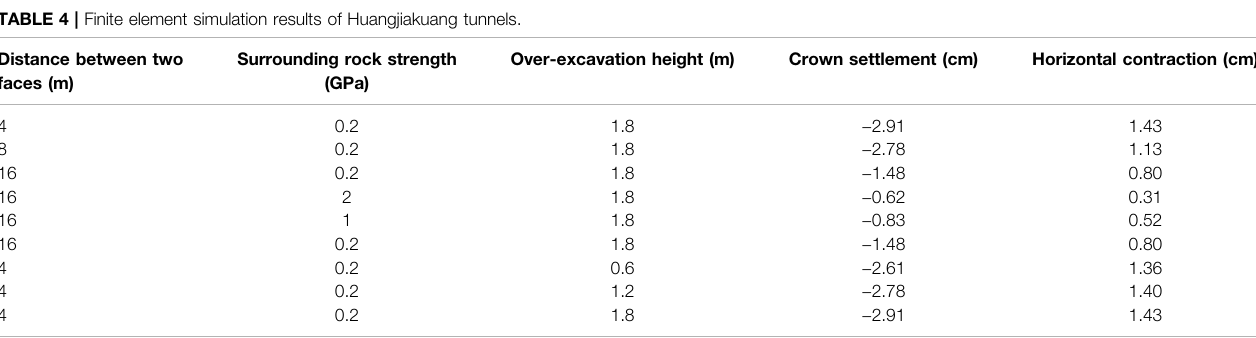
TABLE 4 | Finite element simulation results of Huangjiakuang tunnels. Distance between two faces